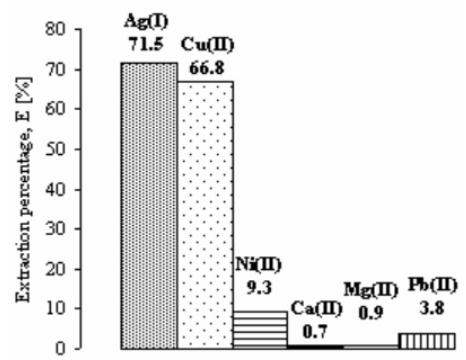
Figure 3. The extraction percentage of different cations by the support studied in pH